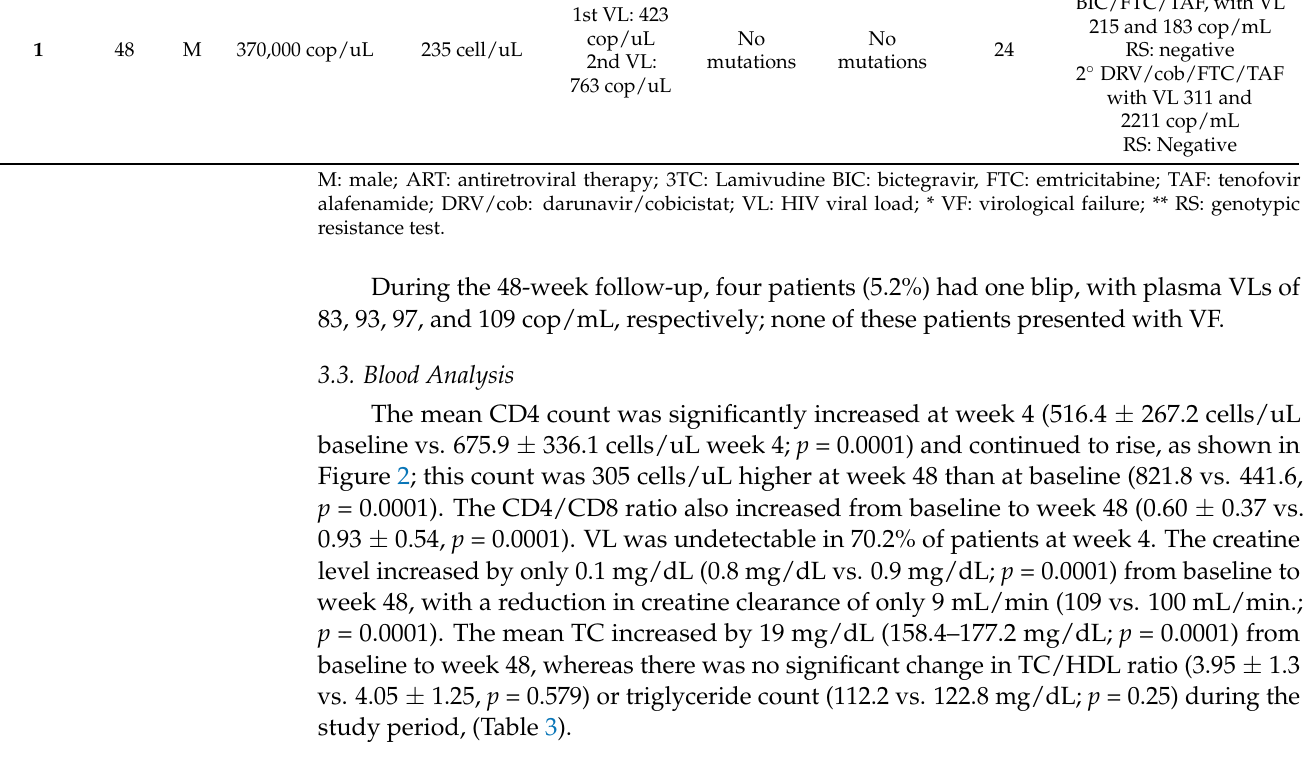
Table 3. Analytical changes between baseline and weeks 4, 24, and